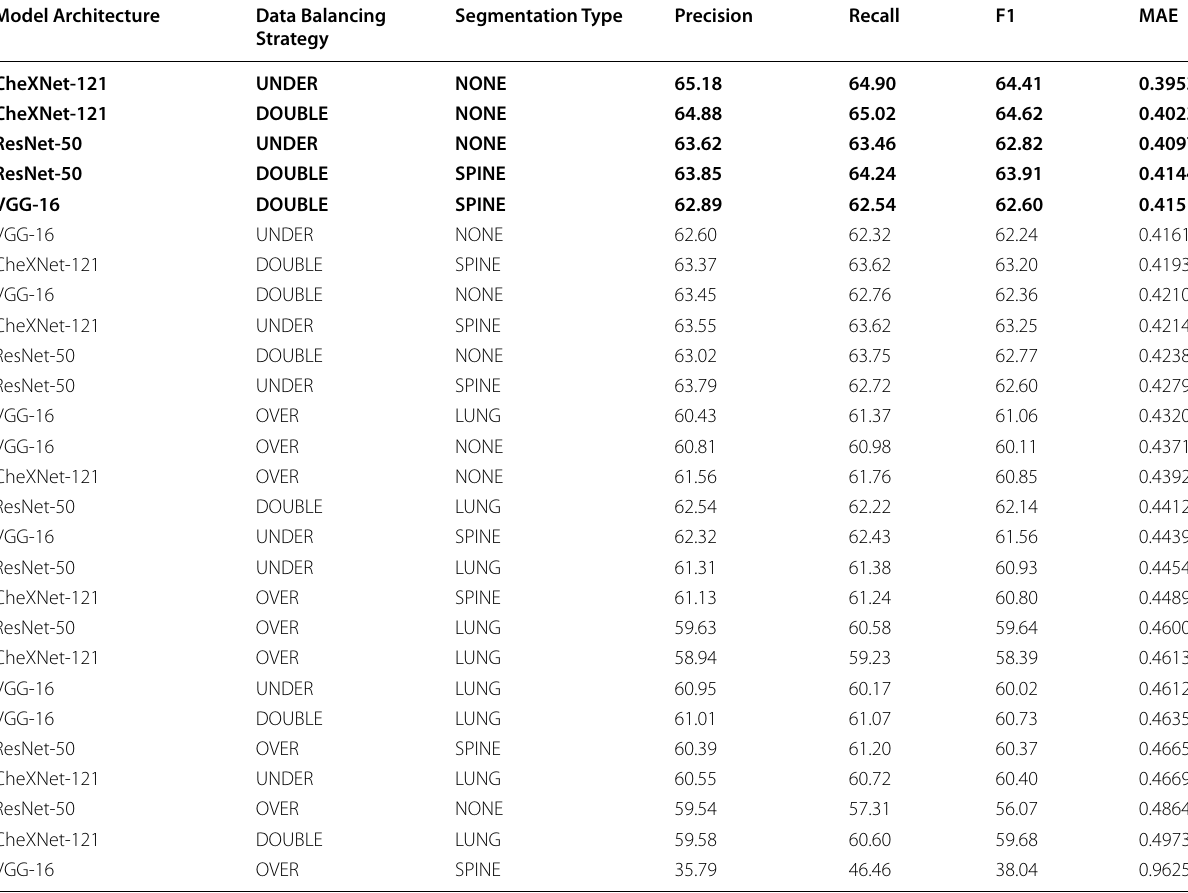
Table 3 Comparison of all models for Fold 1 and choosing top five models by MAE Model